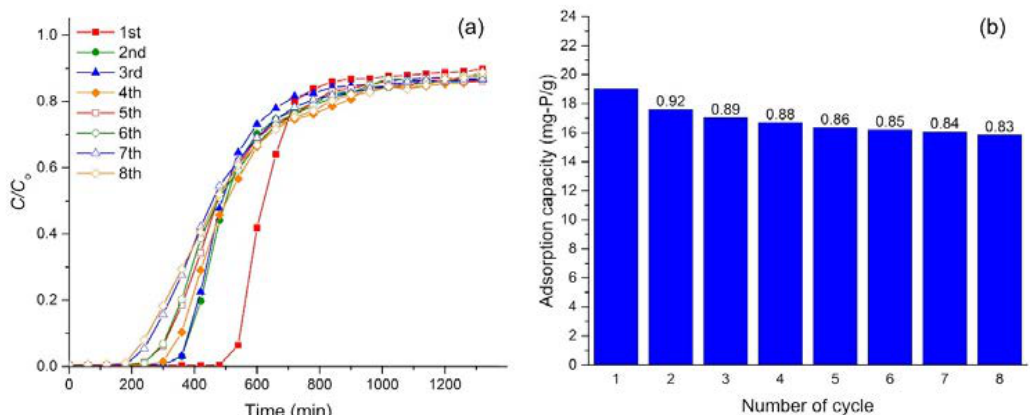
Fig. 5: Column reusability study: (a) phosphate adsorption breakthrough curve on am-Zr/MgFe-LDH composite for each consecutive eight adsorption-desorption cycles at a flow rate 2.5 mL/min, and (b) column adsorption capacity calculated for each adsorption cycle (the numbers above the bar are adsorption retain ratio of phosphate adsorption capacity)